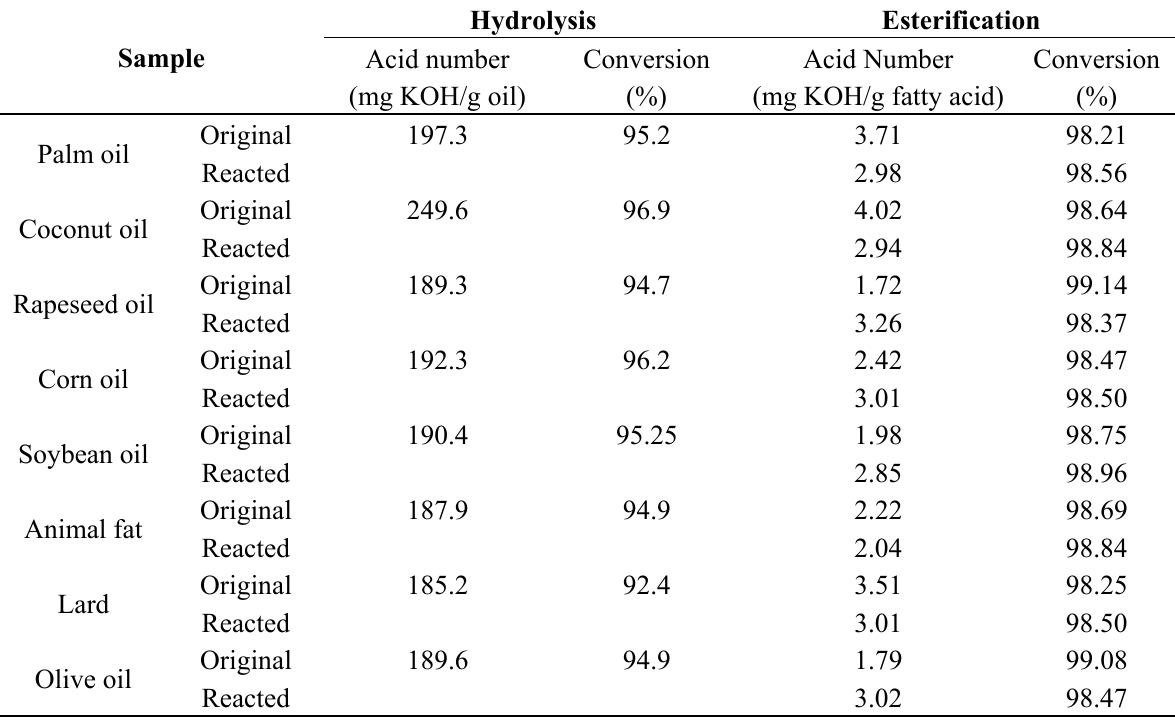
Table 1. Acid number results for hydrolysis and esterification